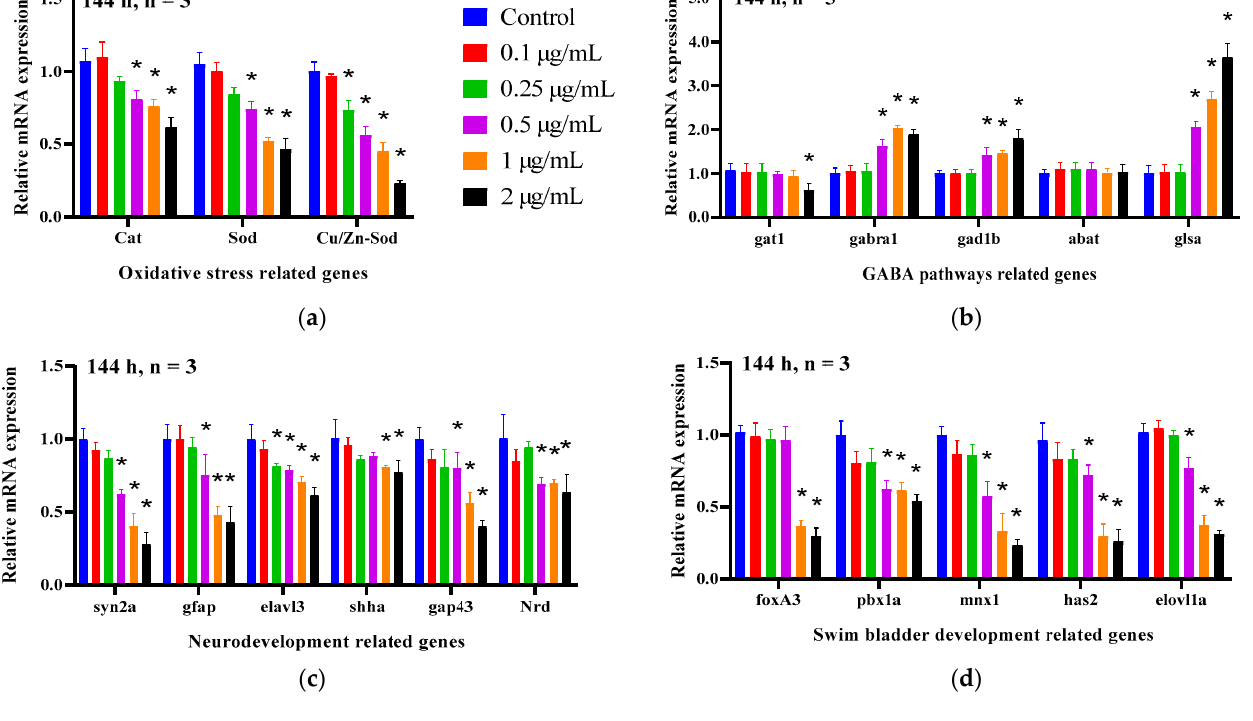
Figure 6. Gene expression changes induced by exposure to EMB. EMB exposure altered oxidative stress ( a ), the GABA pathway ( b ), neurodevelopment ( c ), and swim bladder development-related genes ( d ), (20 larvae pooled as one sample, n = 3). * p < 0.05, compared with the control groups.